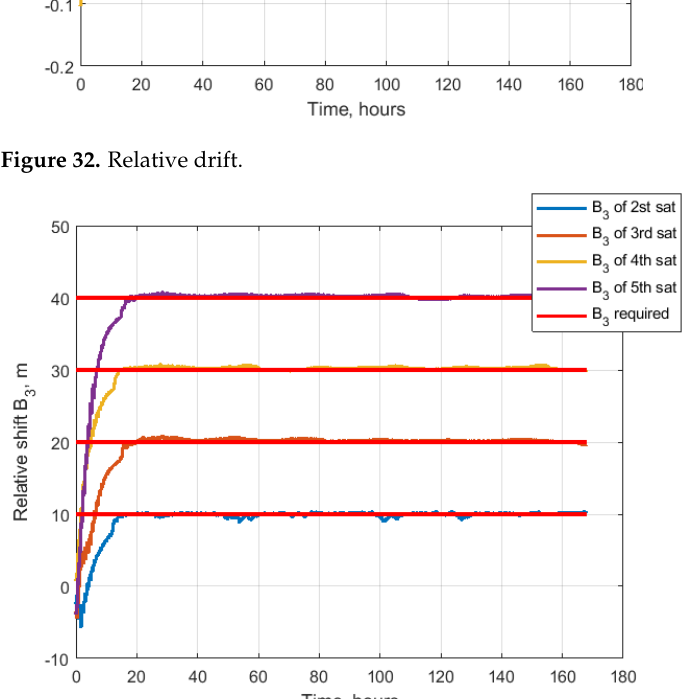
Figure 33. Relative shift.